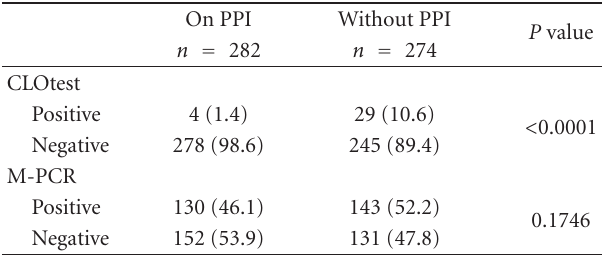
Table 1: Di ff erence between M-PCR and CLOtest. On